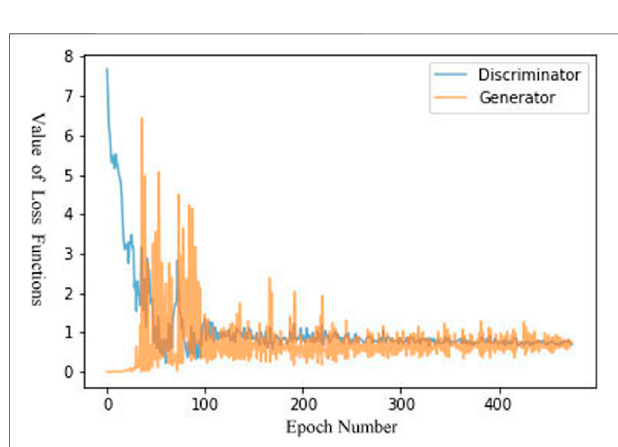
FIGURE5| Variations oftheloss functionwithepochnumber, blueforD and orange for